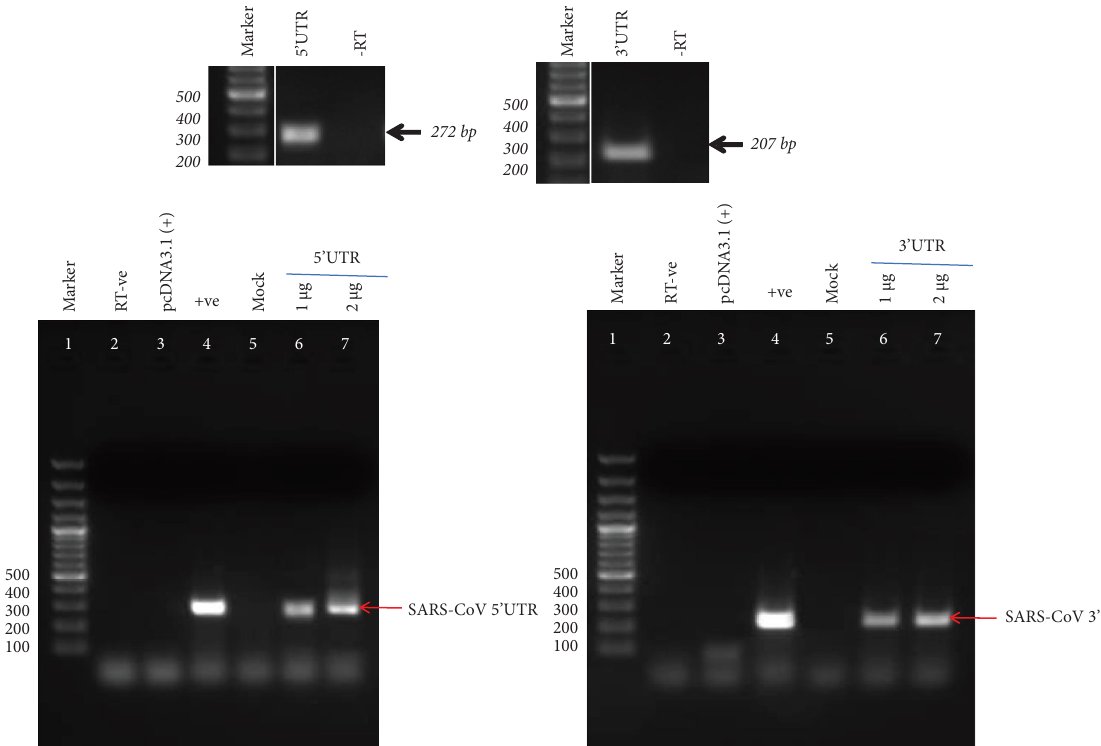
Figure 2: Overexpression of SARS-CoV-2 5 ′ UTR and 3 ′ UTR in HEK293T cells: cells were transfected with plasmid pcDNA3.1 encoding either 5 ′ UTR or 3 ′ UTR of SARS-CoV-2. Total RNA was extracted using Trizol reagent. Te overexpression was validated by RT-PCR using 5 ′ UTR and 3 ′ UTR specifc primers (lanes 6 and 7). Lane 4 depicts a positive control in PCR reaction where pcDNA3.1 constructs having 5 ′ UTR or 3 ′ UTR were used (Table